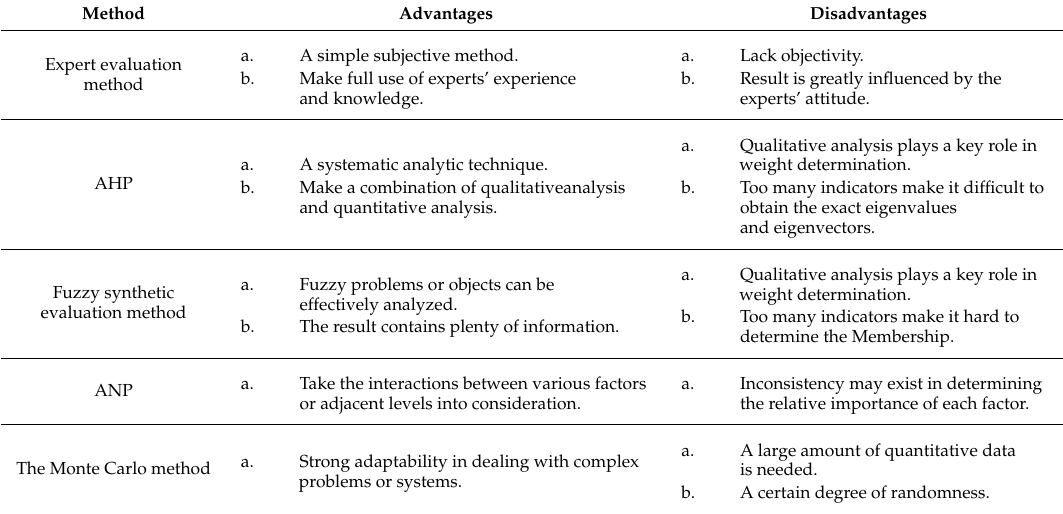
Table 2. The comparison of different risk evaluation